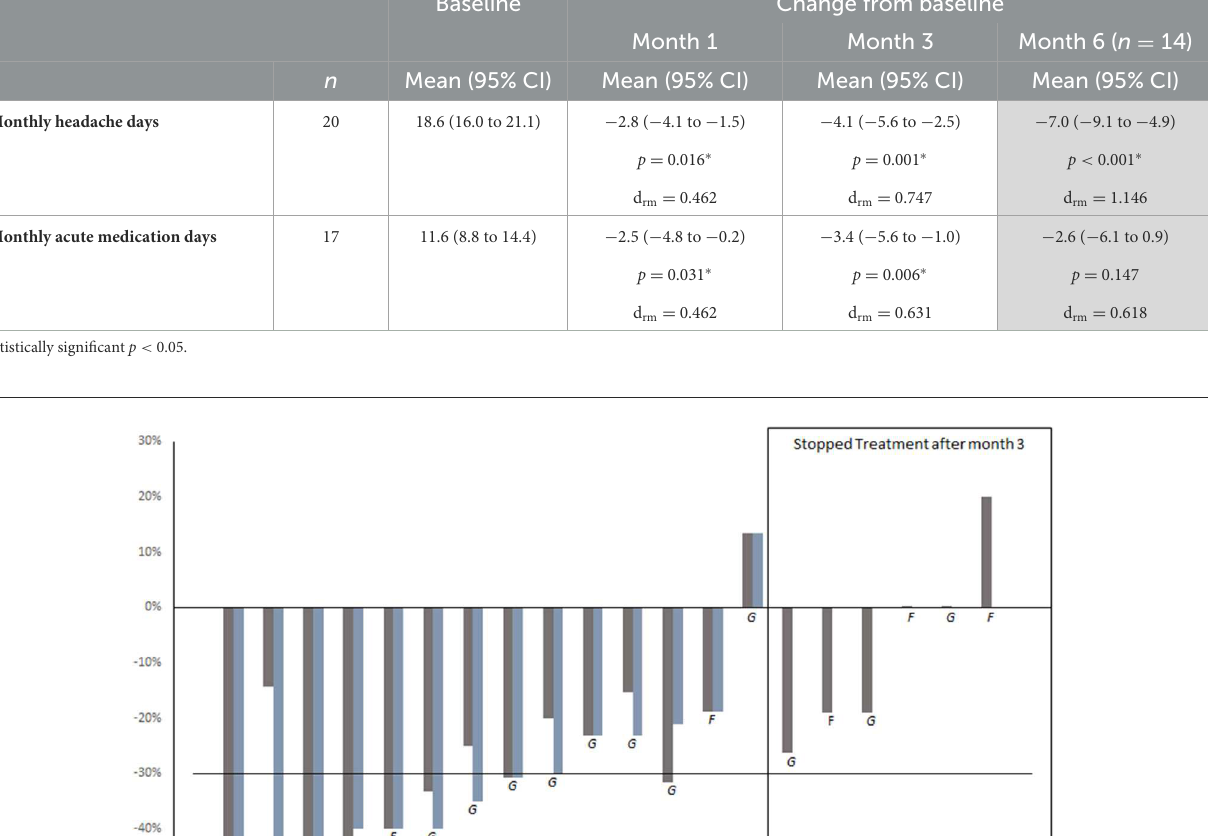
treatments, nor the number of absolute MHD/MMD at baseline and follow-up, nor the number of AMD ( 20). Thus, a comparison with our cohort is limited. Other results on switching between CGRP mAbs have been published in conference posters without available data on the direction of the switch (e.g., CGRP ligand mAb to receptor or vice versa) (28,